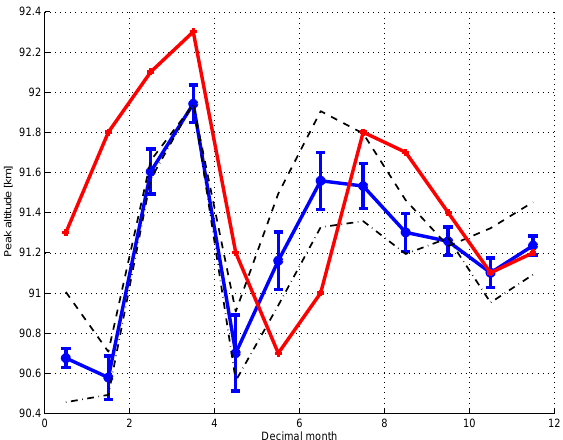
Fig. 11. Peak altitude of the Na layer. Red: Fort Collins climatology (1990-1999); black dashed line: GOMOS data in the 30°N-40°N bin; black dot-dashed line : GOMOS data in the 40°N-50°N bin; blue: GOMOS weighted interpolation at Fort Collins latitude (41°N) and associated error bars.